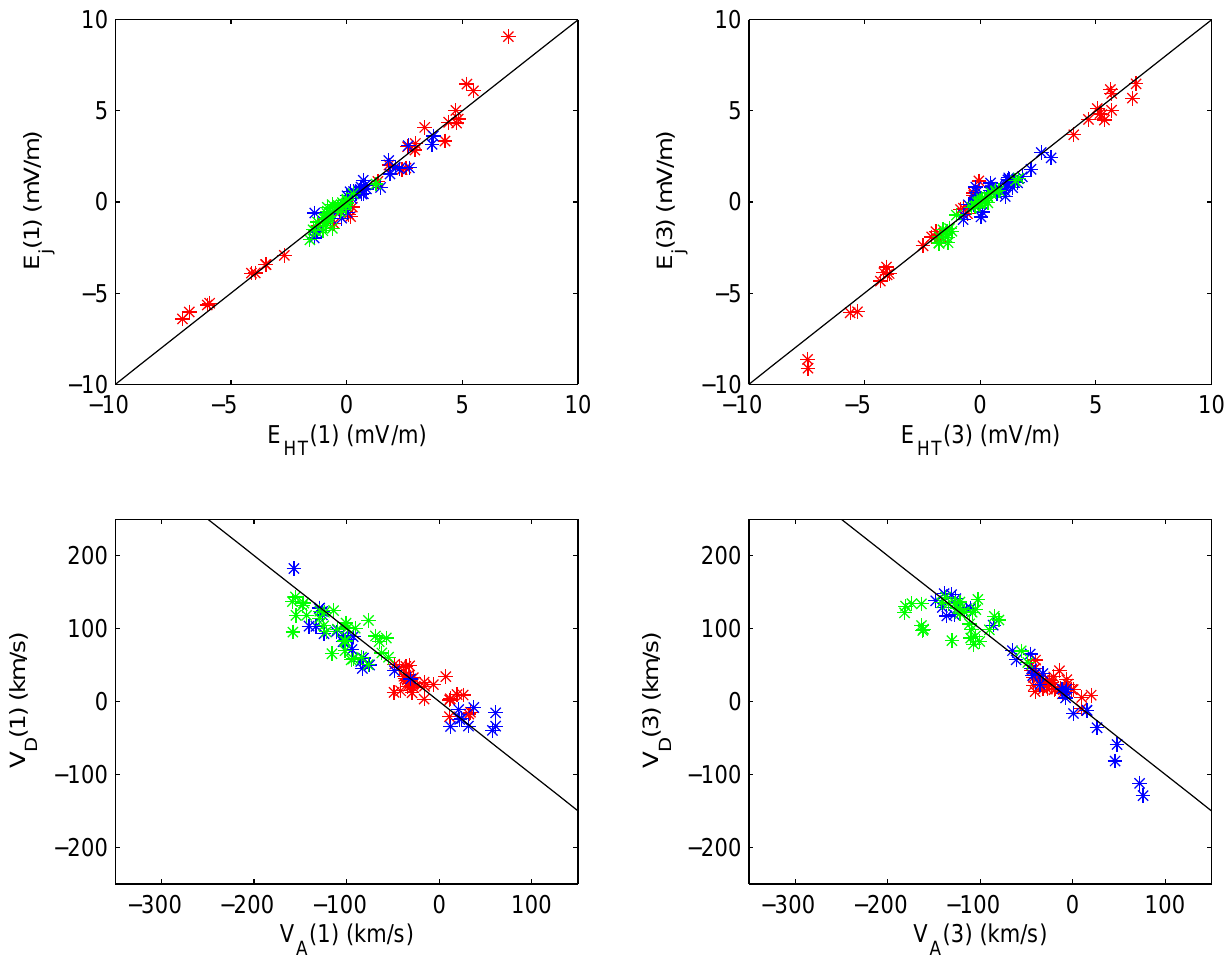
Fig. 7. The upper panels show the relation between E j and E HT for the interval 19:59:30–20:01:30 for spacecraft 1 (left) and 3 (right). The correlation coefficients are 0.983 and 0.987, respectively, indicating the existence of a deHoffman-Teller frame. The lower panels show the relation between v j − V HT and V A for the same time interval. A linear relationship would indicate that the Walen relations were satisfied, and that the boundary was a rotational discontinuity. In all plots, red, blue and green points correspond to the x, y and z components of the relevant vectors. The black lines correspond to a slope of